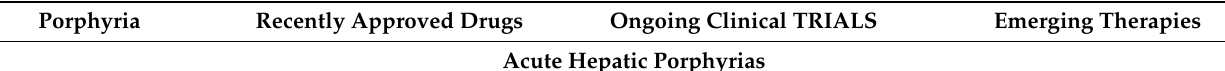
Table 2. Overview of recently approved drugs, current clinical trials and emerging therapies for the treatment of the different types of porphyria. N/A = not